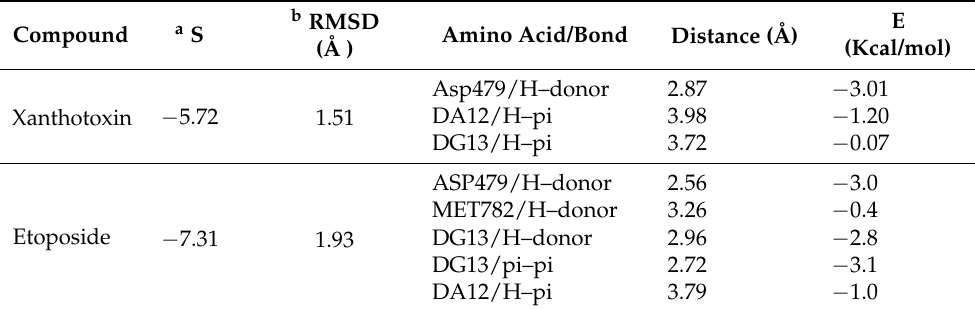
Table 2. The binding scores and modes of Xanthotoxin and the docked co-crystallized inhibitor etoposide inside the binding site of the topoisomerase